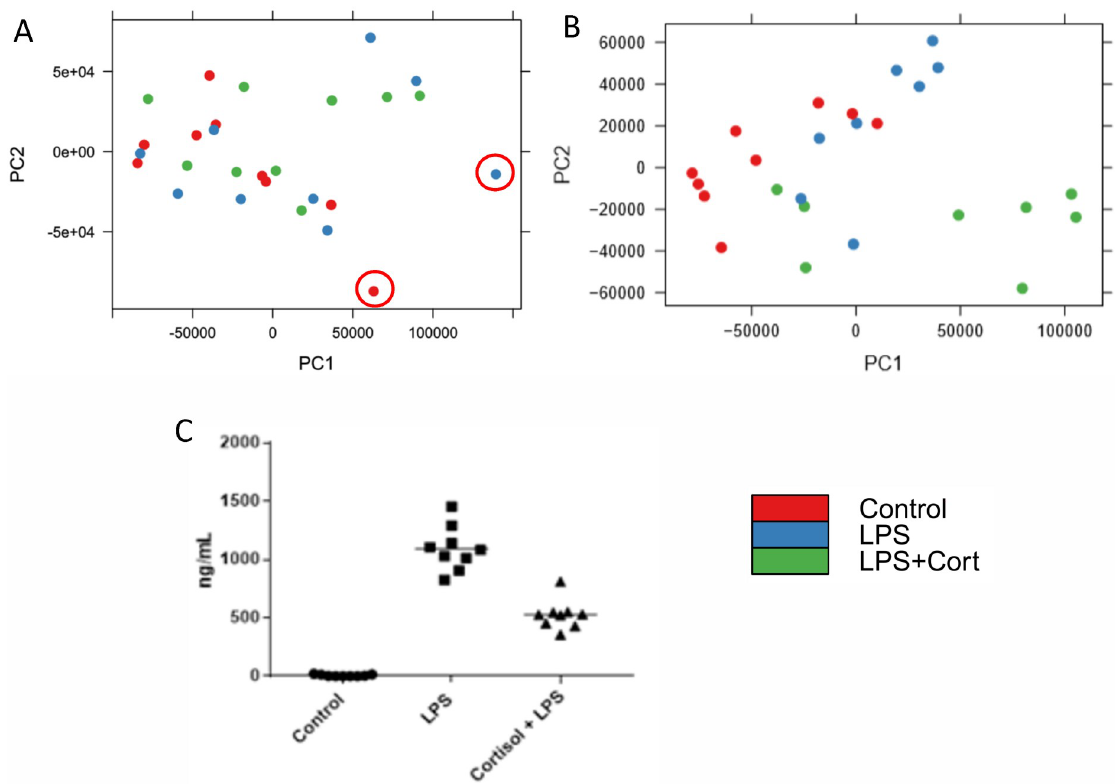
Fig 6. Principal component analysis before (A) and after (B) removal of the arrays determined to be outliers in Fig 5A . The two outliers removed are highlighted in panel A. This data represents 2 treatment groups (blue and green) and one control (red) with 3 biological replicates performed on three different days. C. ELISA data showing differential TNFa levels across the different treatment groups. This shows a strong difference in the immune response, which leads to the expectation that the PCA should show distinct